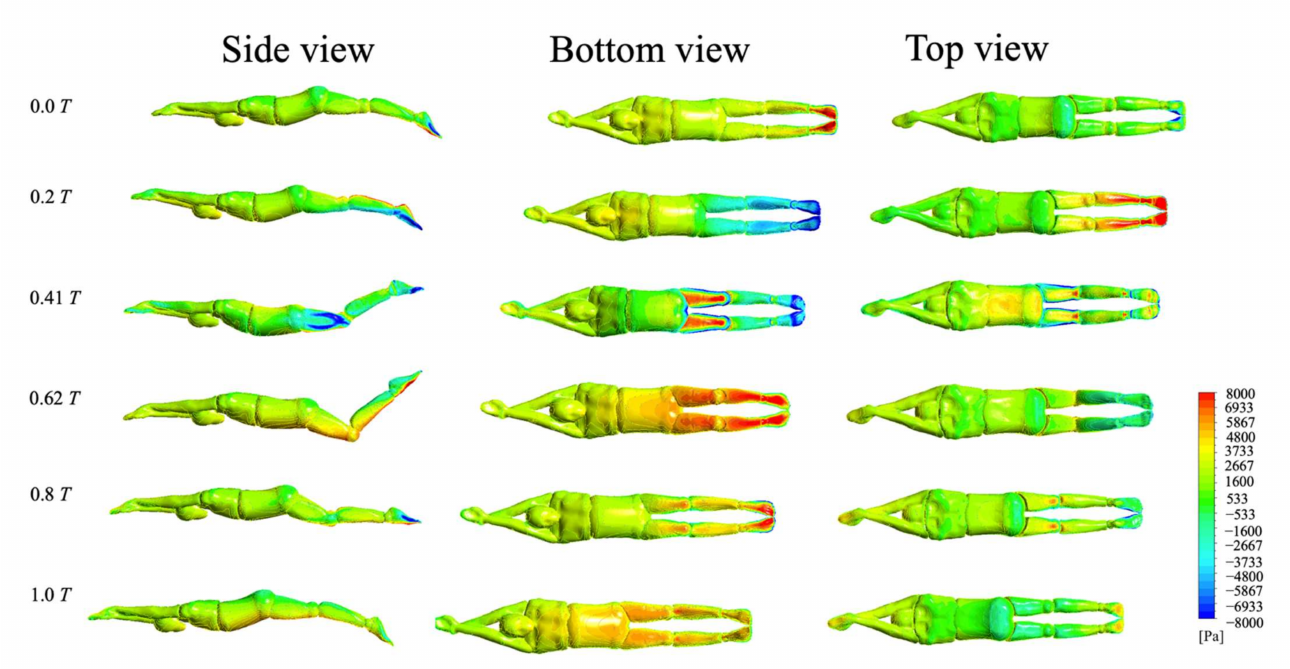
Figure 10. Evolution diagram for the surface pressure of